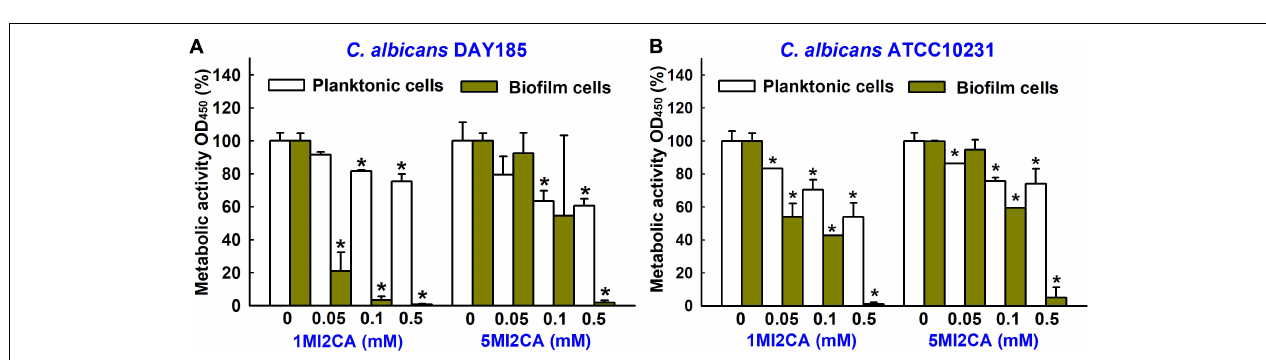
FIGURE 3 | Effects of 1MI2CA and 5MI2CA on the metabolic activity of C. albicans . The metabolic activities of C. albicans DAY185 (A) and C. albicans ATCC10231 (B) planktonic cells and biofilms were quantified in the presence of methylindoles using an XTT reduction assay after incubation for 24 h. Results are presented as mean percentages of metabolic activity vs. untreated controls. Two independent experiments were conducted (six wells per sample); error bars indicate standard deviations. None indicates untreated samples. Error bars indicate standard deviations. ∗ p < 0.05 vs. untreated